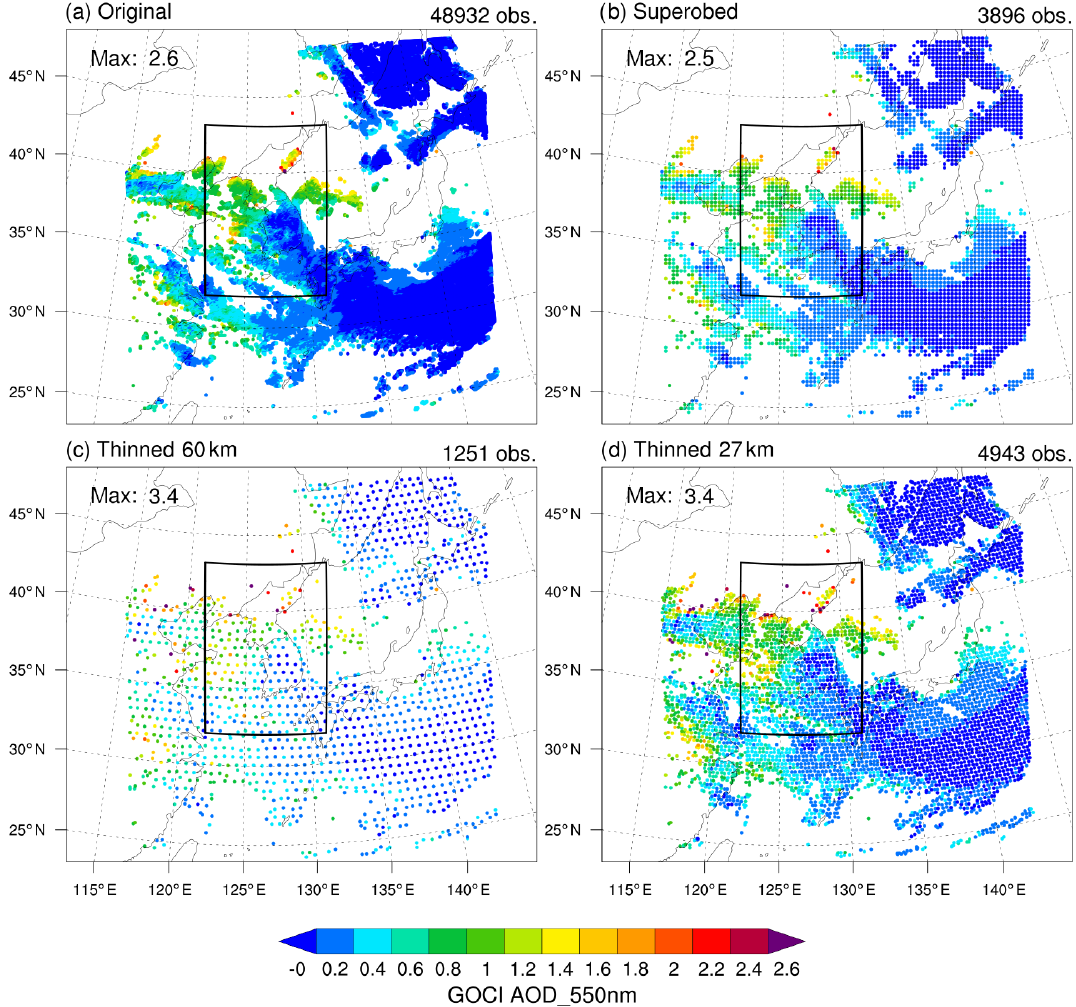
Figure 2. Horizontal distribution of GOCI AOD at 550nm retrieved at 06:00:00UTC on 1 May 2016 in (a) the original level II data at 6km resolution, (b) the preprocessed data at 27km resolution before GSI, and the data thinned over (c) 60km and (d) 27km resolution during the GSI analysis. The total number of observations available for the GSI analysis is shown in the upper right corner of each panel, and the maximum value is in the upper left corner of each map. Domain 2 is marked as a black box in each